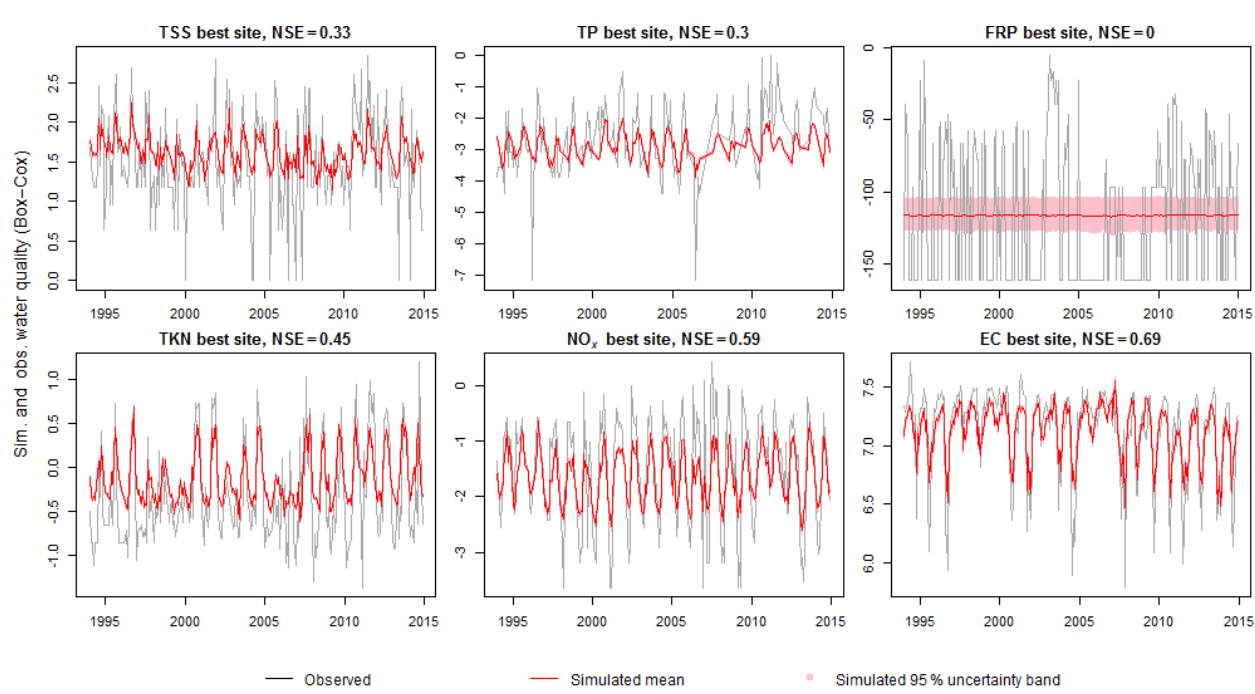
Figure 6. Model fit of the within-site (temporal) water quality variability, illustrated using the observed and simulated time series for the best-performing site for each constituent. All values are presented in Box–Cox-transformed space. The NSE for each constituent is also shown. The red line indicates the corresponding mean of all posterior simulations, and the pink shading shows the corresponding 95% upper and lower bounds (only visible for FRP).